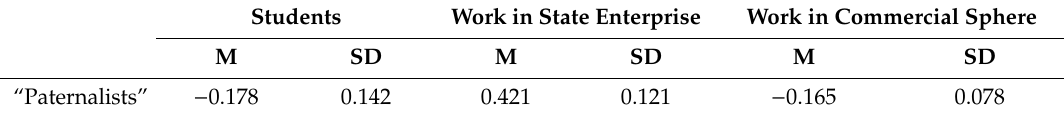
Table 2. Significant di ff erences between groups with di ff erent employment status (N = 304). Students